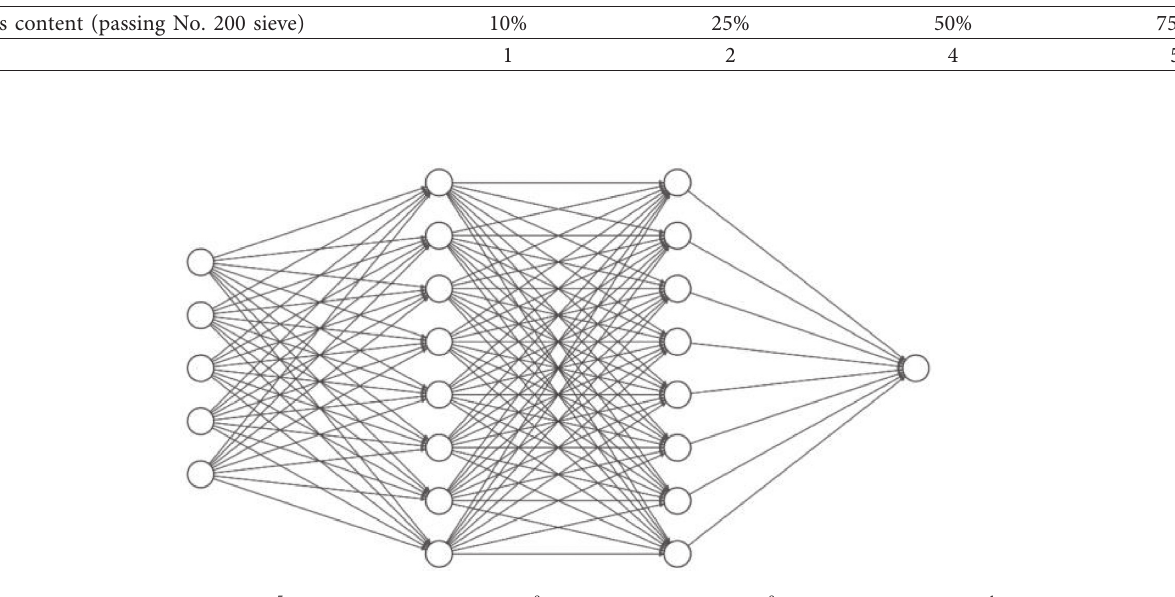
Table 1: N cr for fines